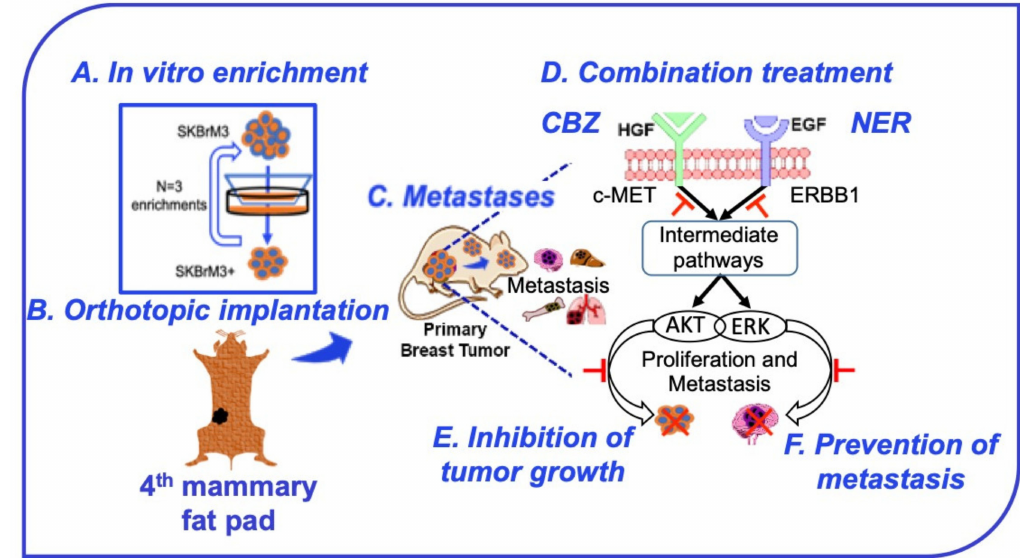
Figure 6. Schematic diagram showing targeted inhibition of the ERBB-c-MET axis to prevent BC metastasis in an orthotopic ERBB2 + mouse model. ( A ) In vitro enrichment of the SKBrM3 cell line using a Boyden chamber. ( B ) Orthotopic implantation of SKBrM3 + cells in fourth mammary fat pads of female nude mice. ( C ) Incidences of metastasis in distant organs including brain, bone, liver, and lung. ( D ) Combination treatment of NER and CBZ after 3 weeks of implantation. ( E , F ) E ff ect of combination therapy on primary tumor growth and